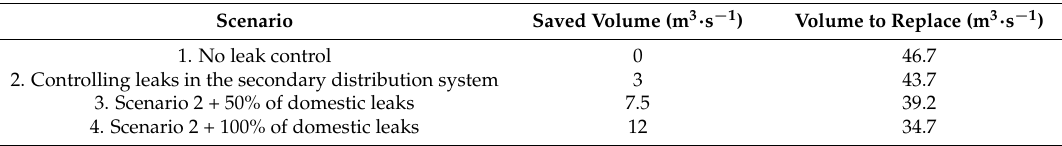
Table 4. Design of scenarios.